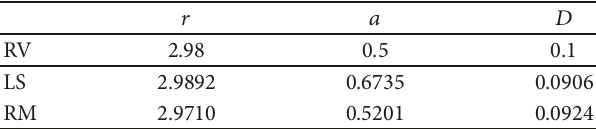
with the regularization parameter 𝜃 ∗ = 1.0875 × 10 −6 . Table 2: Theestimation result whenthesample valuesare generated from special initial value from 𝑡 = 1 to 𝑡 = 10000